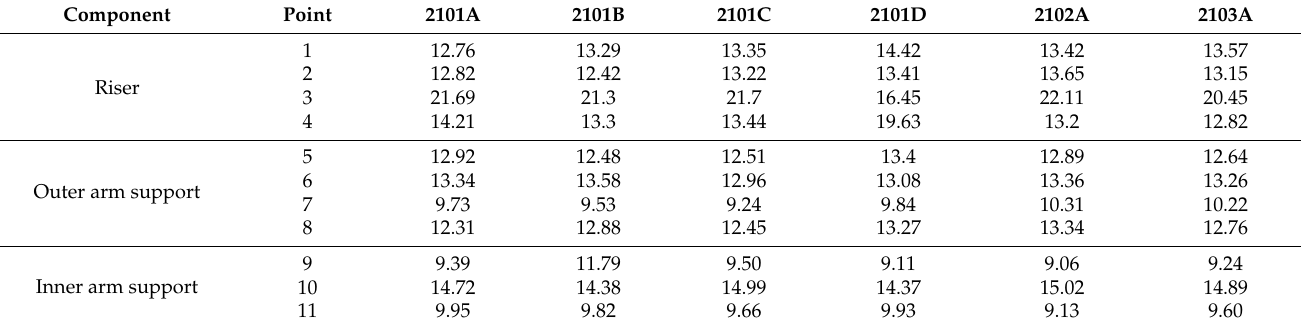
Table 3. Measured thickness from the NDT at sample points (unit: mm).